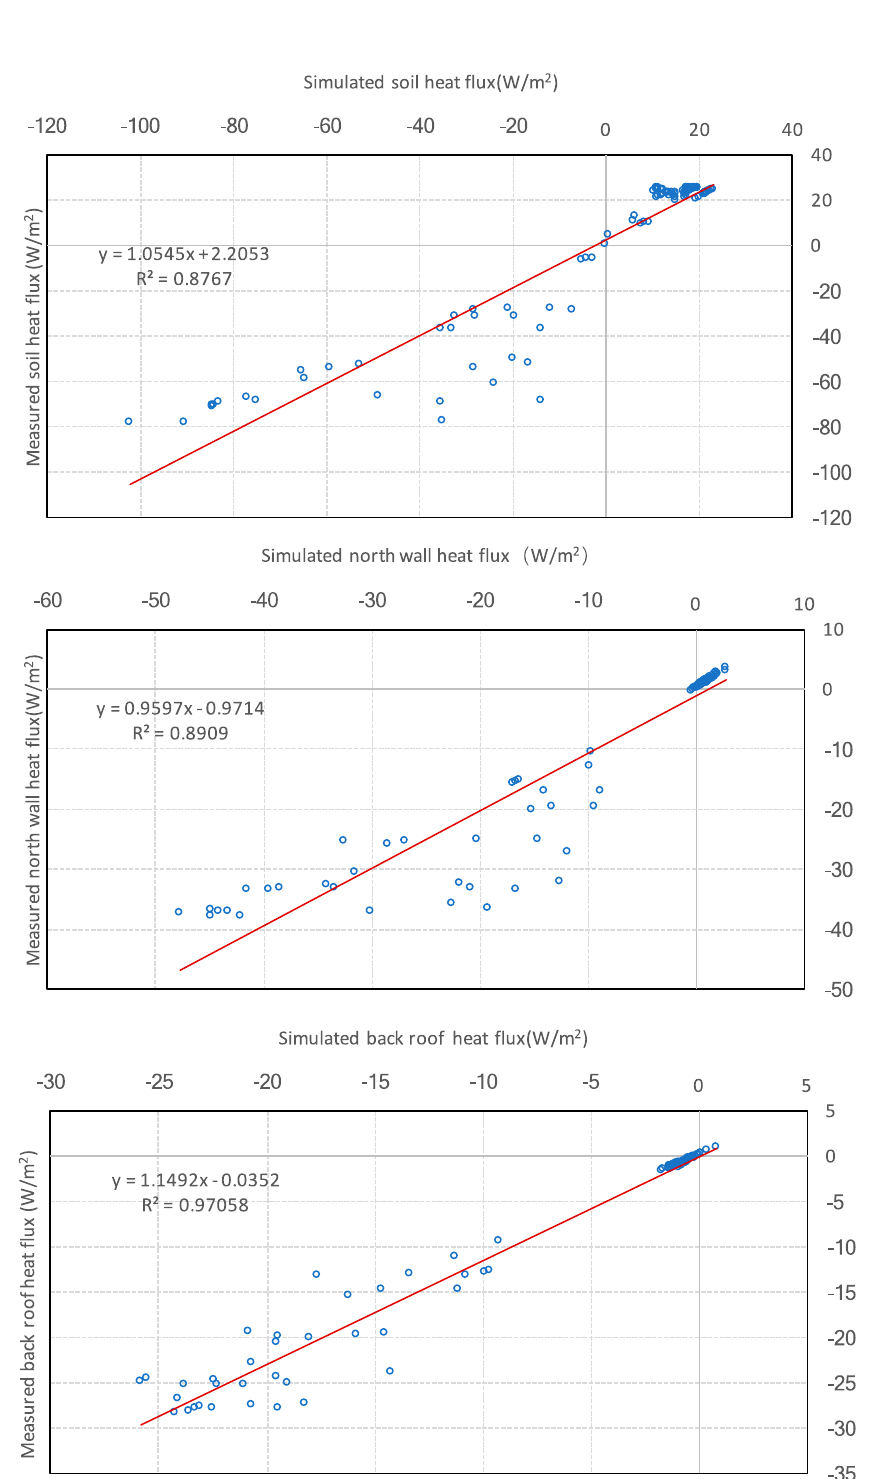
Figure 16. Relationship between simulated and measured heat flux variations during cloudy days.